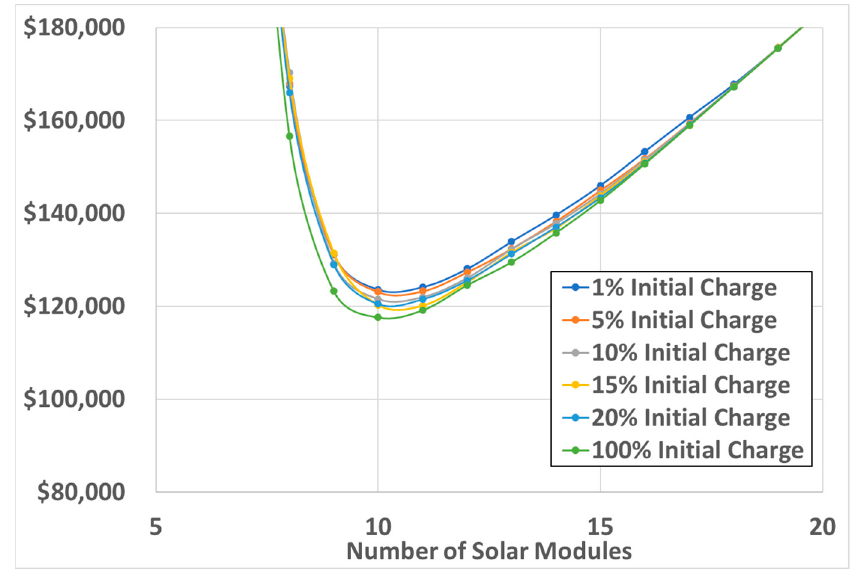
Figure 7. Variable initial charge for IES system given March, five systems, Indianapolis, 0.1% LPSP.